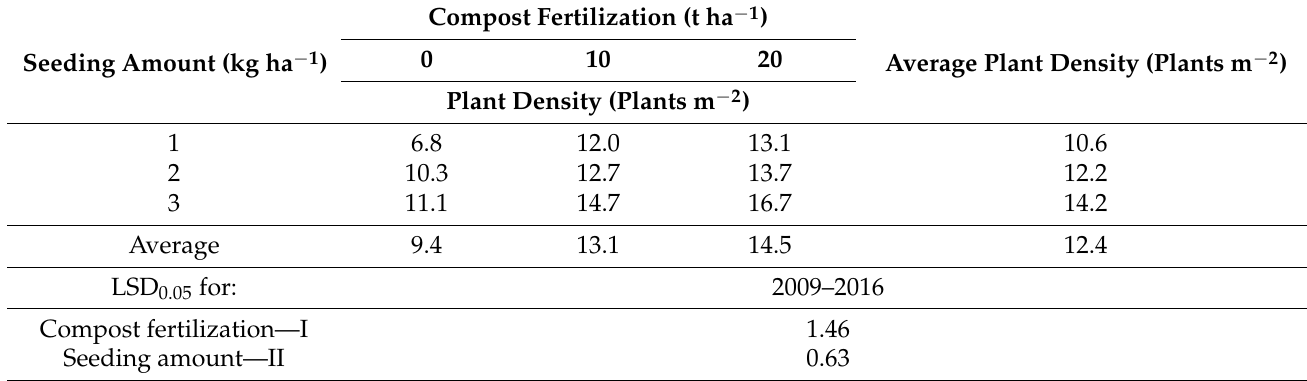
Table 3. Effects of seeding amount and fertilization with compost on the Sida plant density during the years of full use